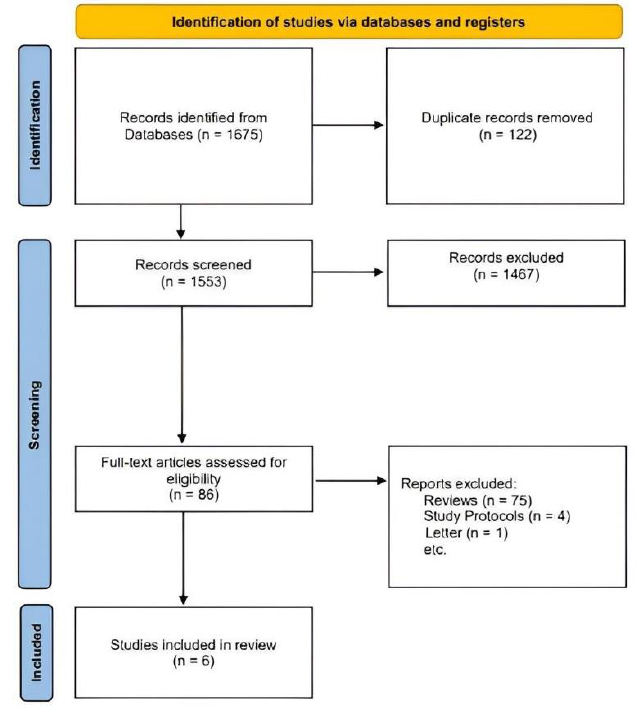
Figure 1. Flowchart of study selection. Table 2. Characteristics of included studies.